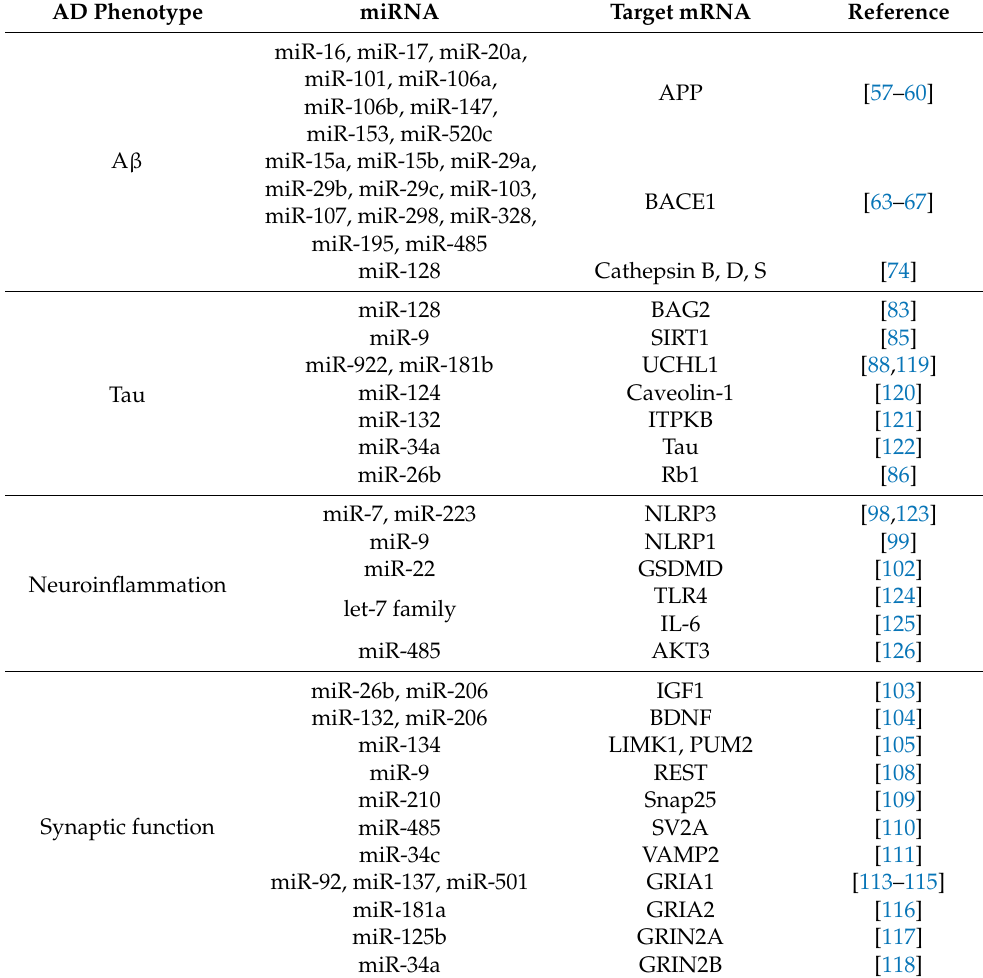
Table 2. AD-related miRNAs and their